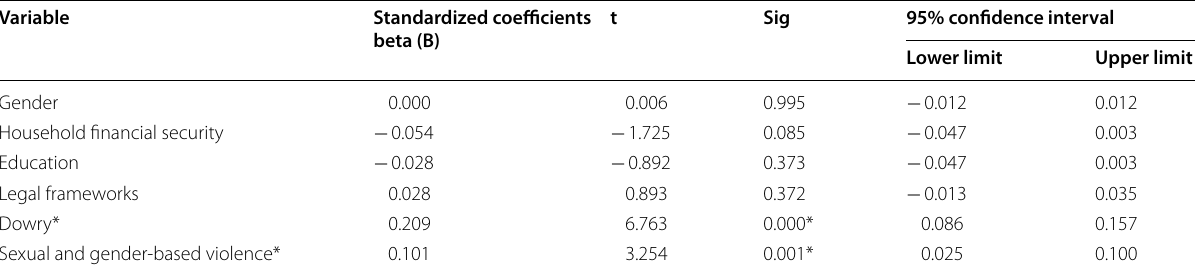
Table 7 Regression